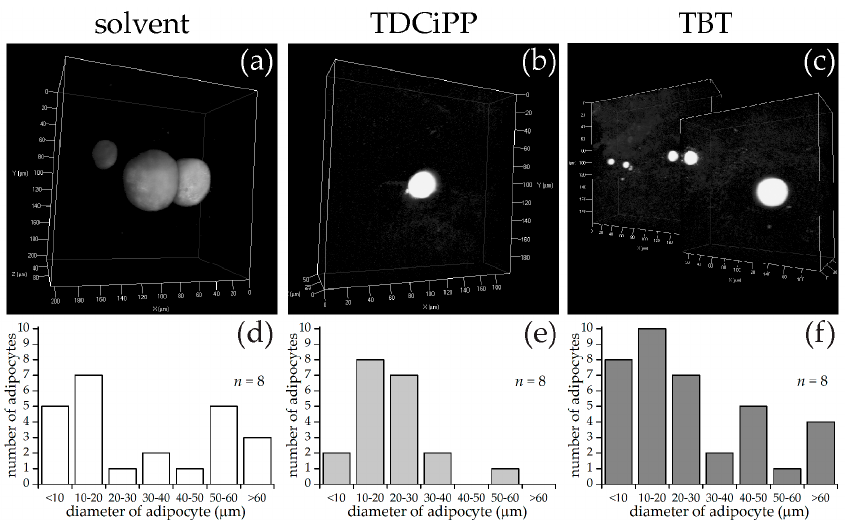
Figure 8. SRS imaging of adipocytes in fish exposed to environmental chemicals. ( a – c ) Representative images of volumes of SRS lipid measurements following solvent control (0.01% DMSO), 0.5 µM TDCiPP, or 1 nM TBT exposure, respectively; ( d – f ) Frequency of adipocytes in different size classes of solvent control ( n = 8), TDCiPP ( n = 8) or TBT ( n = 8) respectively, determined by an automated image processing algorithm in MATLAB.